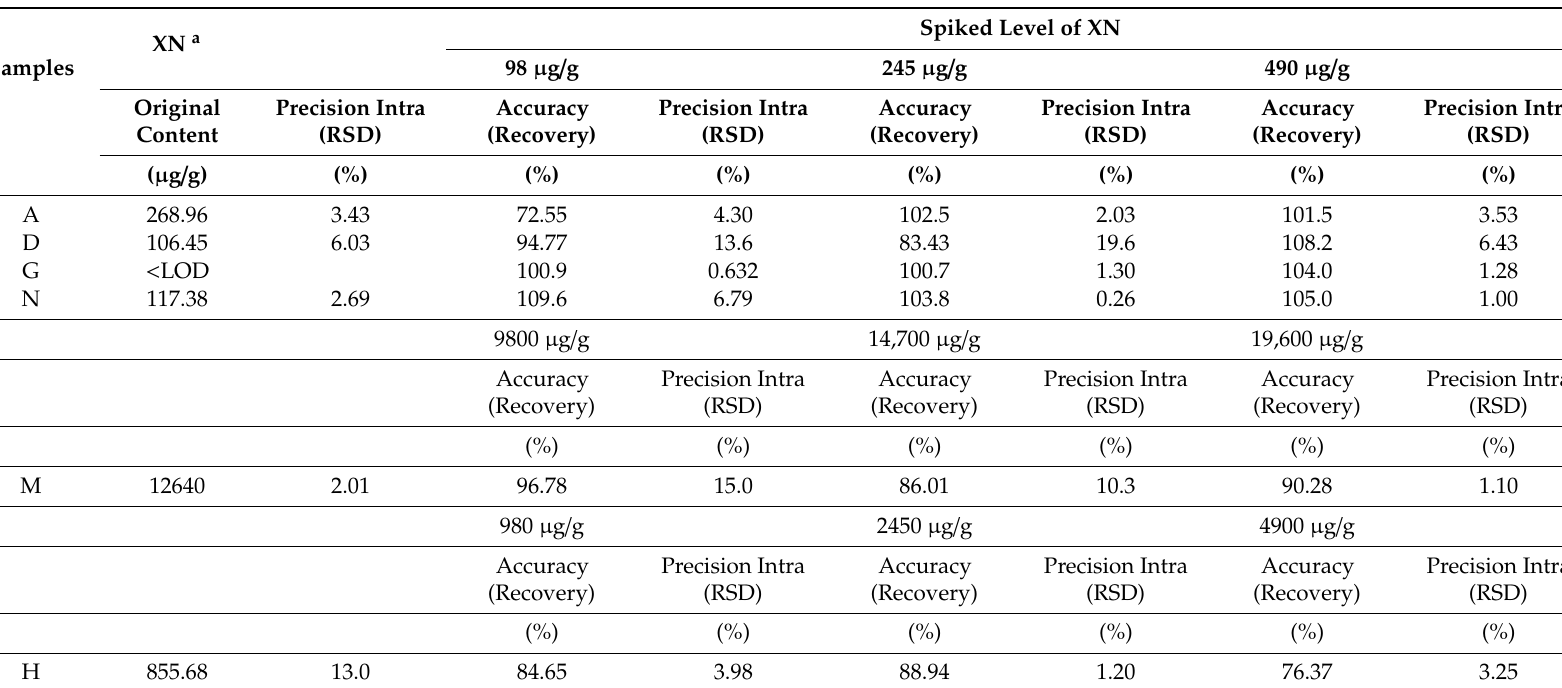
Table 5. Accuracy and precision of the Ultrasound (US)-assisted extraction-HPLC-DAD method for hops and food supplements at three concentration levels of XN ( n =